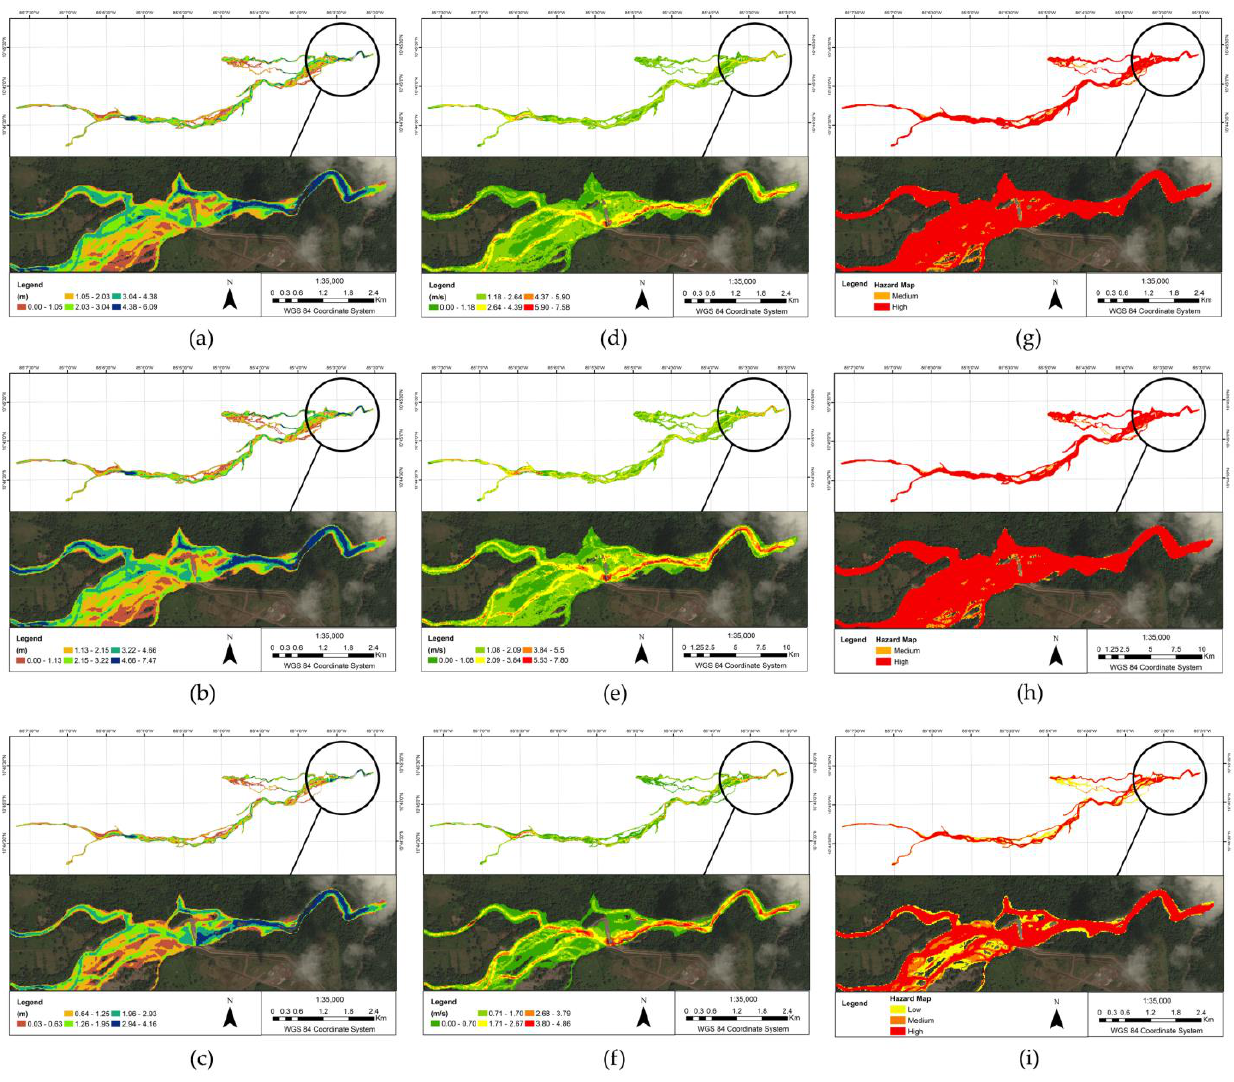
Figure 5. Flood maps results for debris flow simulation using a Cv of 0.45 and rainfall sources as the rain gauge, 100-year return period, and Hydro-Estimator: ( a – c ) flood depth maps, ( d – f ) flood velocity maps, ( g – i ) flood hazard maps.